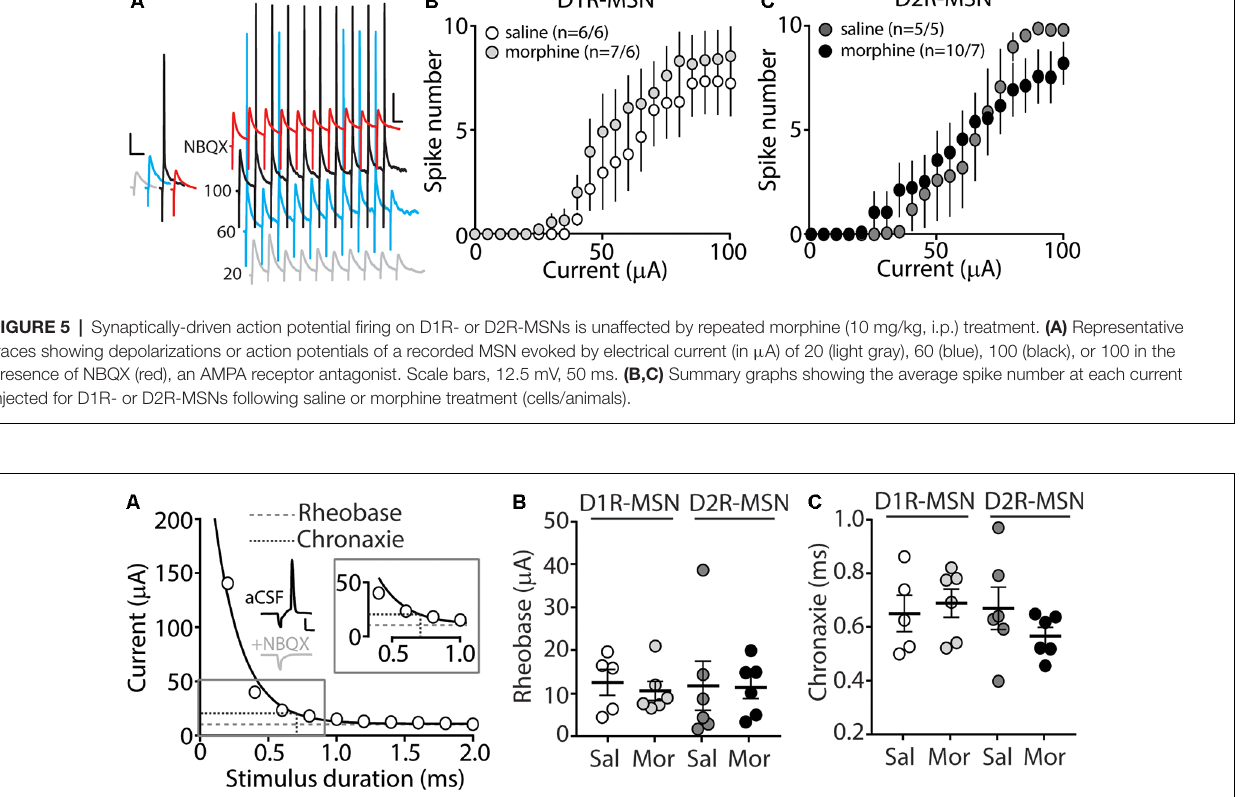
FIGURE 6 | (A) A strength-duration curve constructed from an MSN in the nucleus accumbens shell. Stimulus current was adjusted at each duration (from 0 to 2.0 ms with 0.2 ms increments) until an action potential was evoked using an electrical stimulus. The curve was fit with a two-phase exponential decay. The rheobase (gray dashed line) was calculated as the plateau of the curve and the chronaxie (black dashed line) was calculated as 2 × the rheobase (Inset). Representative traces illustrating the stimulus (downward deflection) followed by the action potential at 2 ms duration). In the presence of NBQX (2 µ M), action potentials are not elicited (2 ms duration, 35 µ A of current). Scale bars, 20 mV, 12.5 ms. (B) Summary graph showing the average rheobase for D1R- or D2R-MSNs following saline (Sal) or morphine (Mor; 10 mg/kg, i.p.) treatment. (C) Summary graph showing the average chronaxie for D1R- or D2R-MSNs following saline or morphine